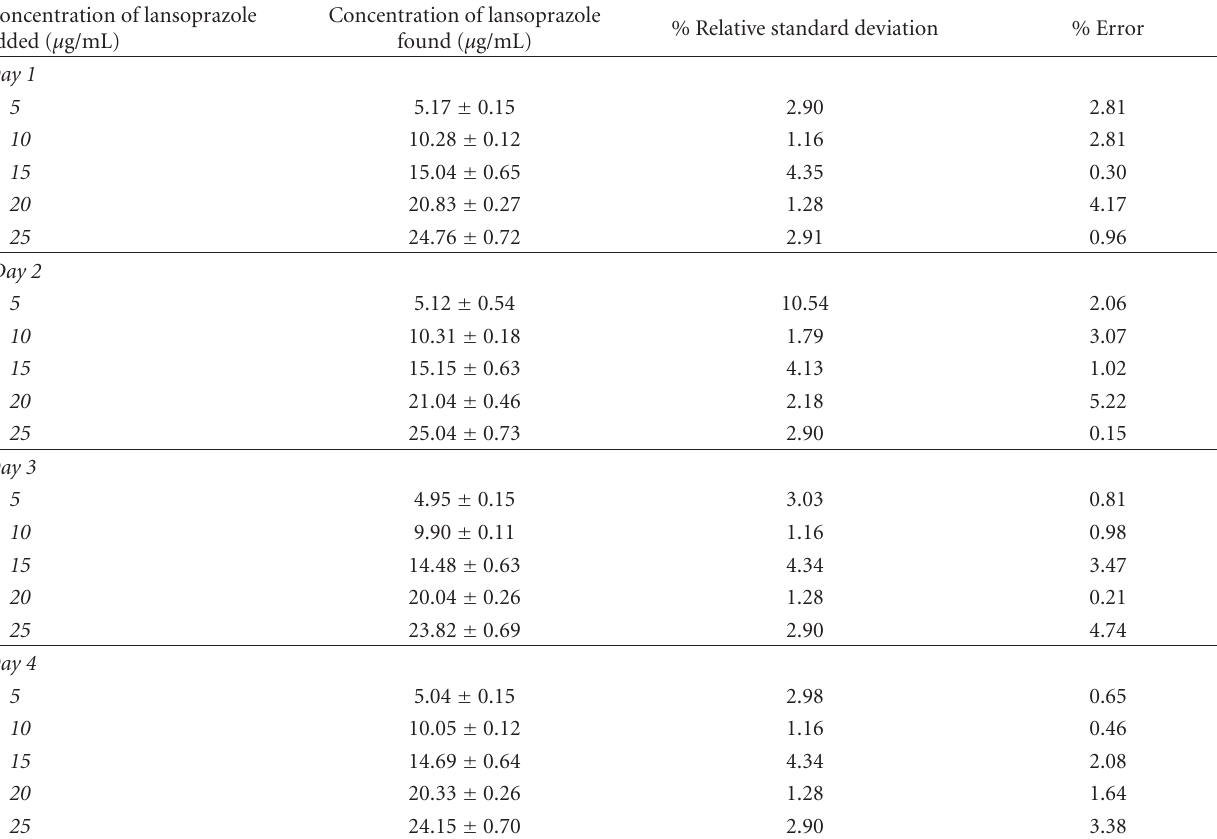
Table 1: Intraday precision (% relative standard deviation (% RSD)) and accuracy (% error) of the LC-MS/MS assay for quantification of lansoprazole ( n = 5 for each concentration for each day).